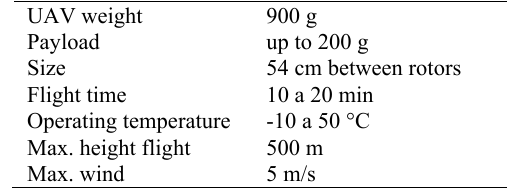
Table 5. Technical specifications of TLS, Faro Focus